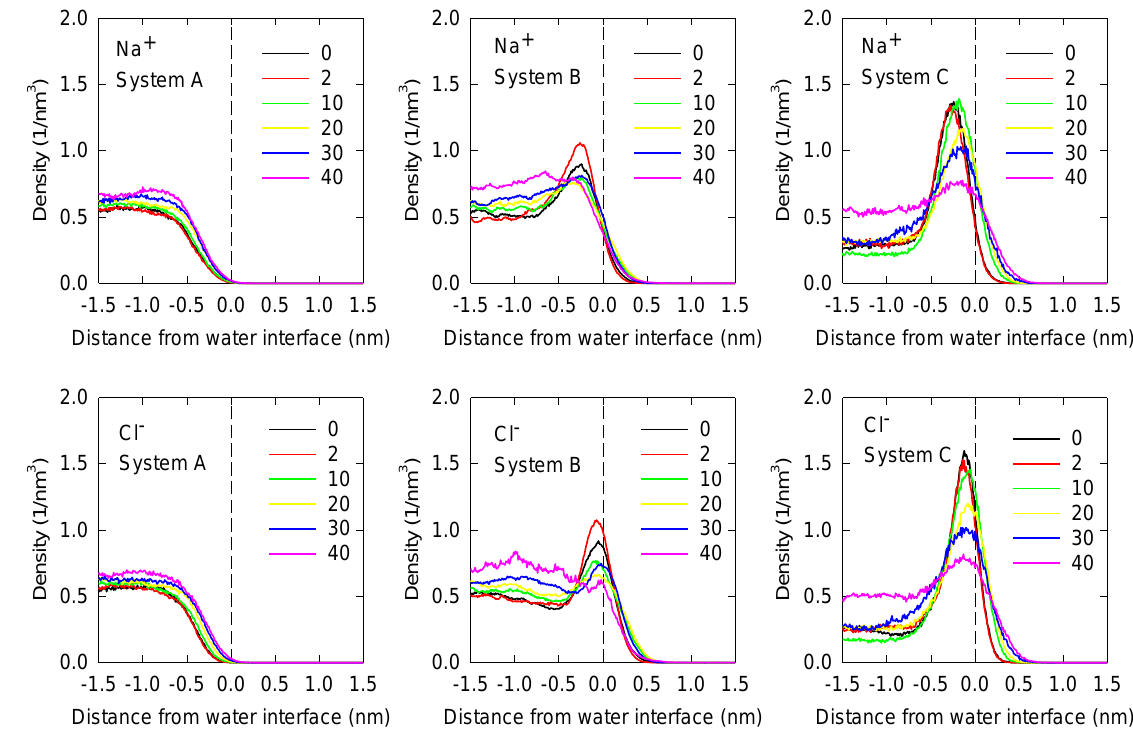
Figure 5. Density profiles of Na + and Cl − ions in the vicinity of the water liquid–vapor interface for the three systems of interest (Table 2). Negative distances correspond to liquid phase. The number of MIBC molecules is in the legends.